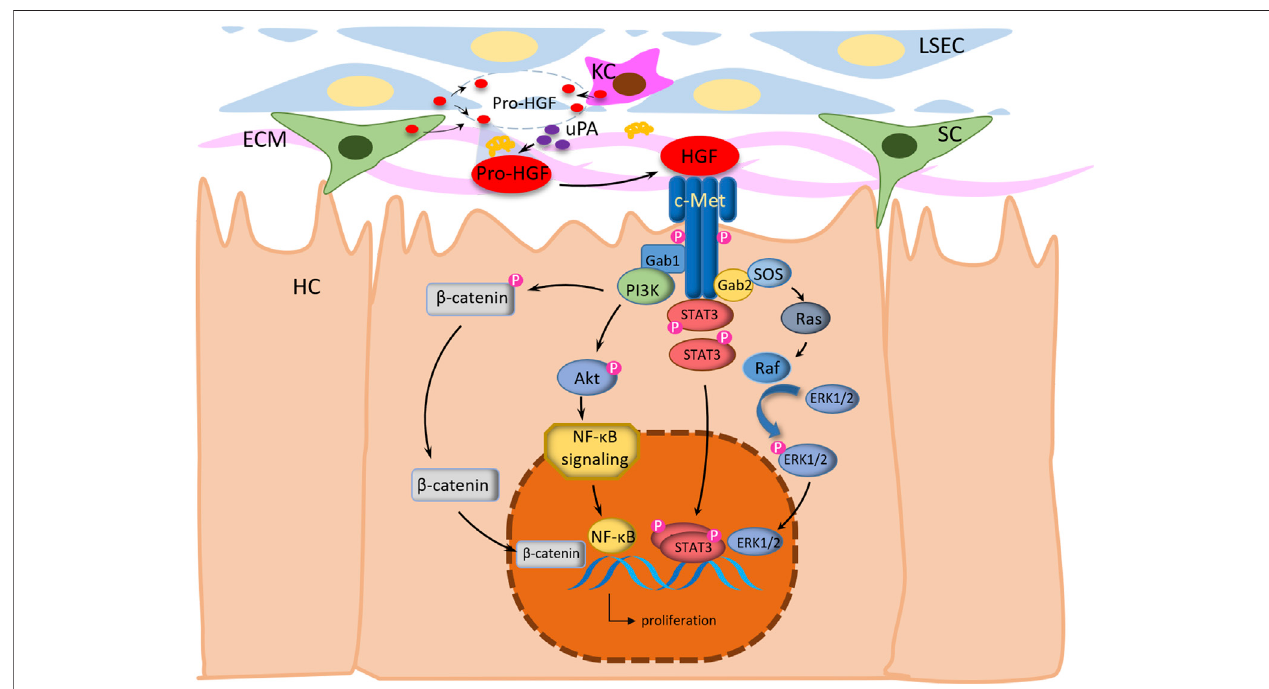
FIGURE 2 | Molecular mechanism of HGF regulating liver regeneration after PHx. HGF is secreted by hepatic stellate cells (HSC), vascular endothelial cells (LECs) and Kupffer cells (KCs). Generally, HGF is sequestered by heparinlike proteoglycans in its inactive form and distributing widely in the extracellular matrix of most tissues. After PHx, inactive Pro-HGF is stored in the liver extracellular matrix (ECM) and can be activated by urokinase-type plasminogen activator (uPA). The activated HGF bindingtothec-Metdrivesthephosphorylationoftyrosineresiduesandinducesnucleartranslocationof β -catenininhepatocytes.Inresponsetoc-Metstimulation and the ensuing activation of PI3K, NF- κ B signaling is activated, resulting in the nuclear translocation of NF- κ B and transcription. Signal transducer and activator of transcription 3 (STAT3) monomers bind to c-Met and become trans -phosphorylated, followed by homodimerization and translocation into the nucleus for operate as a transcription factor. Meanwhile, the HGF/c-Met signaling activates Ras by the GRB2-SOS complex, then activates Raf to phosphorylate ERK1/2. Thus, HGF/c-Met signaling is transferred from extracellular to nucleus to activate transcription of a variety of transcription factors essential for liver